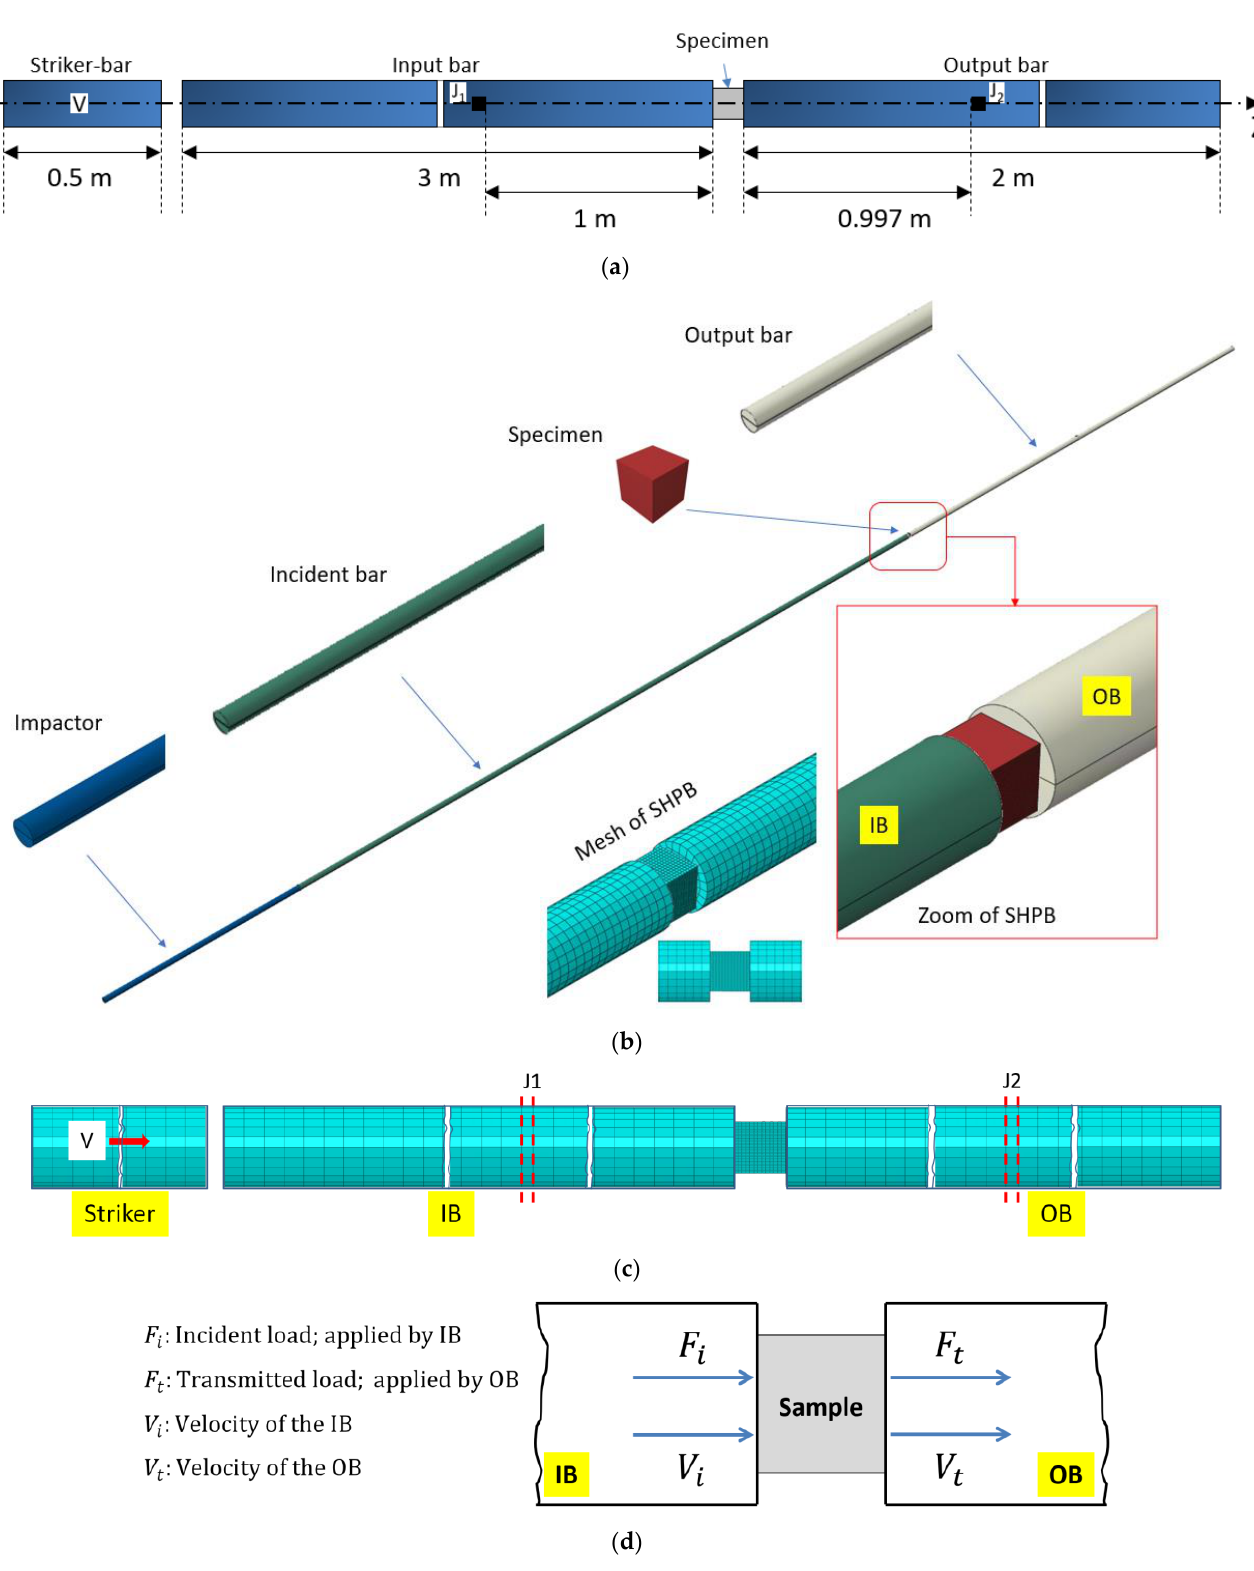
Figure 4. FEA of split Hopkinson pressure bars. ( a ) Geometry of the SHPB system. ( b ) Details of the finite element model. ( c ) Mesh and boundary conditions. ( d ) Parameters for the comparison between experimental and numerical results. Test_Inc: experimental incident load, applied by IB ( 𝐹 i ). Test_Tran: experimental transmitted load, applied by OB ( 𝐹 t ).